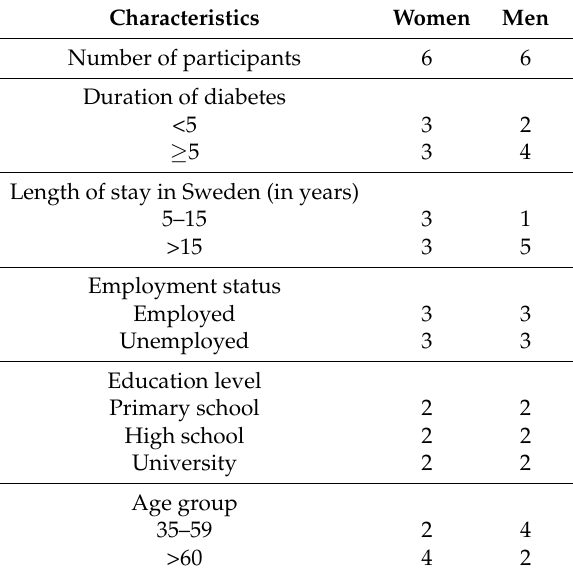
Table 1. Characteristics of participants with type 2 diabetes.